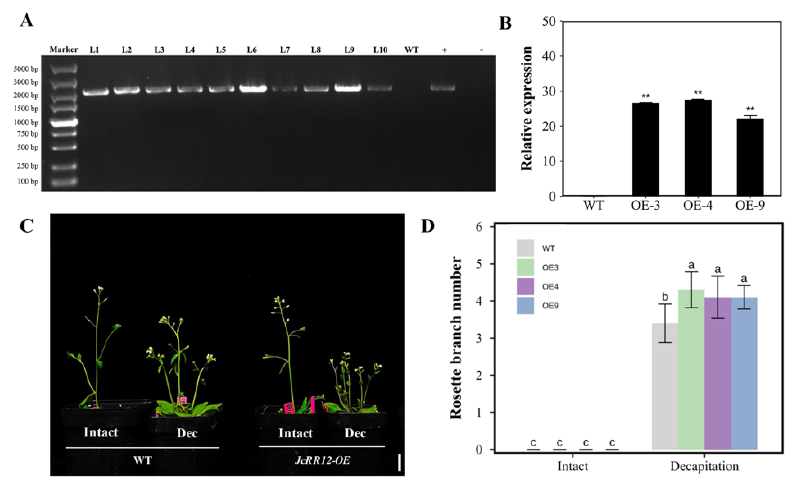
Figure 10. Phenotypic changes in 35S:JcRR12 transgenic Arabidopsis . ( A ) PCR identification of 35S:JcRR12 transgenic Arabidopsis . WT, wild type negative control; +, plasmid positive control; − , ddH 2 O negative control. ( B ) qRT-PCR analysis of JcRR12 expression in WT and transgenic Arabidopsis (OE-3, OE-4 and OE-9). The qRT-PCR results were obtained from three biological replicates and three technical replicates. The values were normalized to the expression of AtActin2 . The error bars represent the standard deviations (SDs). Student’s t -test was used to determine significant differences between transgenic and WT Arabidopsis. Significance levels: **, p < 0.01. ( C ) Phenotypes of WT and transgenic Arabidopsis after decapitation (Dec) treatment. Scale bar = 1 cm. ( D ) Number of rosette branches of WT and transgenic Arabidopsis after mock, 6-BA and decapitation treatments. The values are presented as the means ± standard deviations. Different letters indicate significant differences ( p < 0.05, n = 10, one-way ANOVA, Tukey ’ s test).